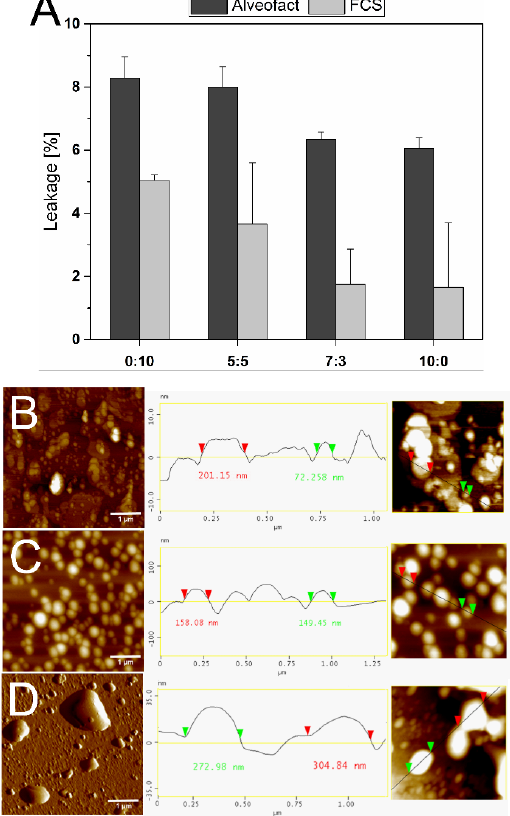
Figure 5. ( A ) The leakage of 5(6)-carboxyfluorescein from liposomes composed of tetraether lipids (TEL) and Phospholipon 100H (Ph) in different molar ratios (0:10, 5:5, 7:3, 10:0; TEL:Ph) after incu- bation for 4 h with Alveofact and fetal calf serum (FCS), respectively. AFM images displayed in height or phase mode of ( B ) 0:10 TEL:Ph liposomes after incubation for 4 h with FCS, ( C ) 7:3 TEL:Ph liposomes after incubation for 4 h with Alveofact, and ( D ) 0:10 TEL:Ph liposomes after incubation for 4 h with Alveofact. Scale bars represent 1 µm.